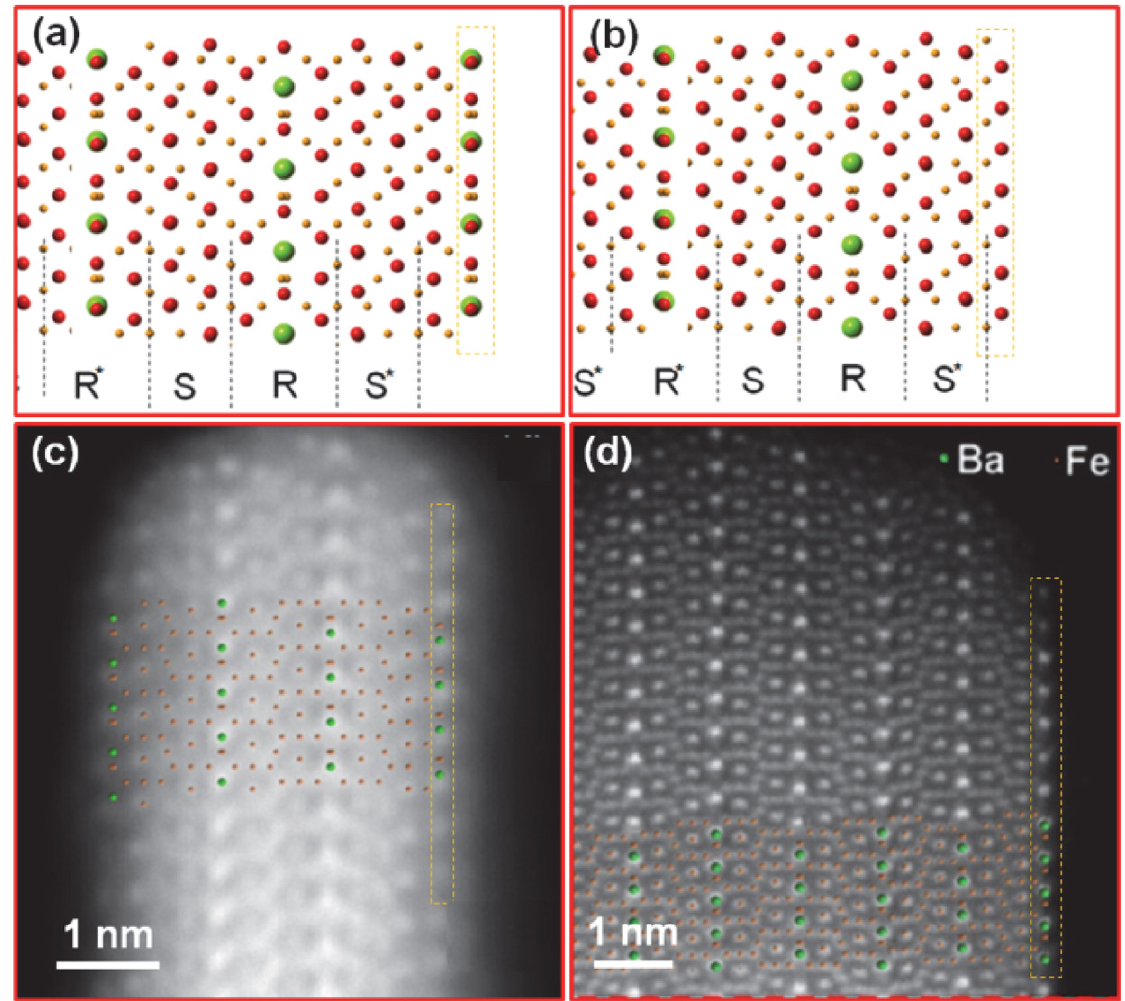
Figure 3. Two structural models schematically representing the structure across the hexaferrite NPL before (a) and after (b) washing with dilute nitric acid. Figures (c) and (d) show HAADF STEM images of BHF NPLs after washing with diluted acid (c) and after annealing for 2 hours at 700 °C. The projected magnetoplumbite structure is superimposed over the images (c) and (d) to illustrate the positions of the Ba 2+ and Fe 3+ columns. The termination layer at the basal surfaces of the NPLs is marked with a yellow rectangle. ( Adapted from the publication by D. Makovec, B. Belec T. Goršak, D. Lisjak, M. Komelj, G. Dražić, S. Gyergyek, Nanoscale 2018, 10, 14480–14491 with permission from The Royal Society of Chemistry. 7